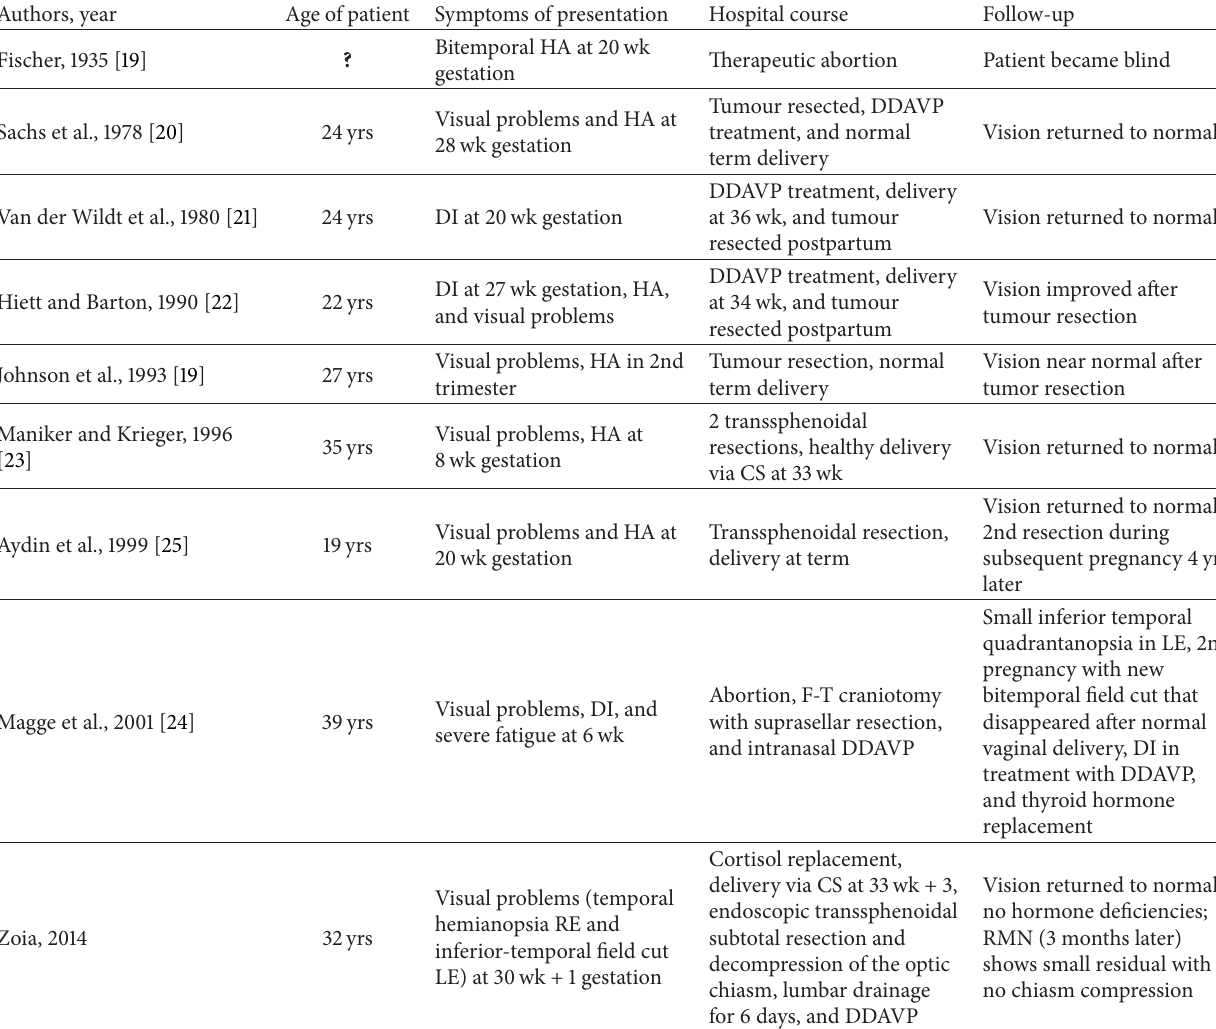
Table 2: Case reports of craniopharyngiomas during